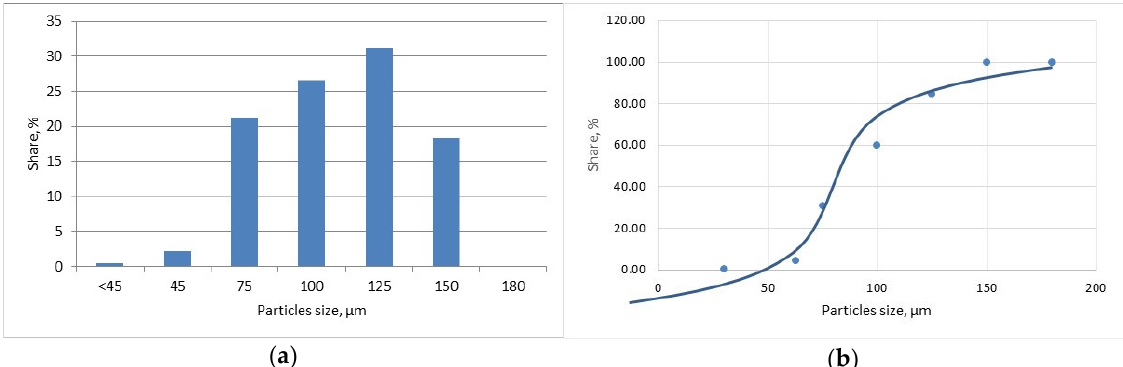
Figure 3. The mass fraction share ( a ) and cumulative particle size distribution curve ( b ) of the experimental composite powder NiCrBSi/WC + W 2 C, Table 1.